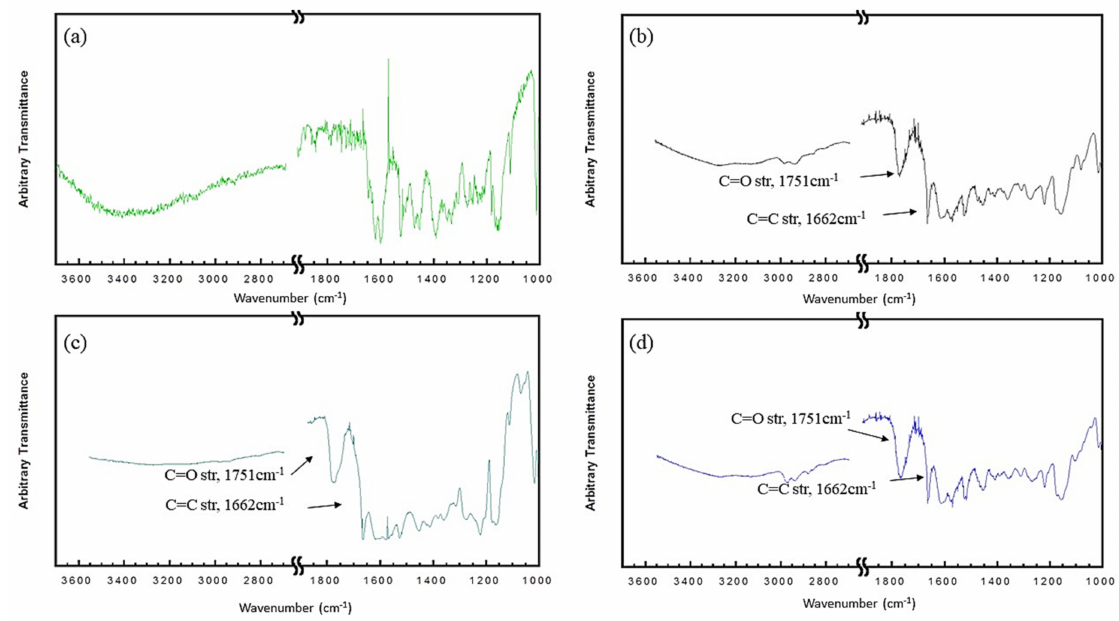
Figure 2. Fourier-transform infrared spectra of ( a ) resveratrol, ( b ) resveratrol acetate, ( c ) resveratrol propionate, and ( d ) resveratrol